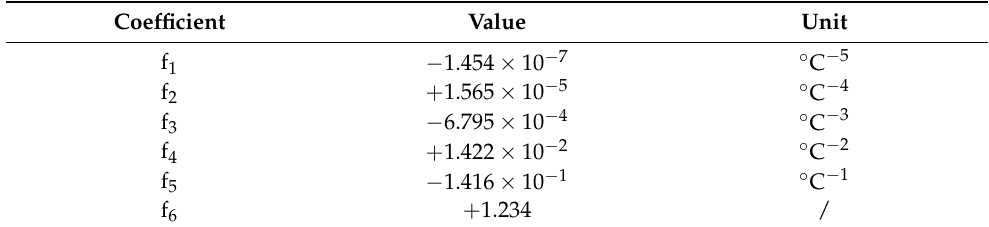
Table 3. Coefficients for Equation (8) used for calculating the sensible fraction of the heat emission. Coefficient Value Unit f 1 − 1.454 × 10 −